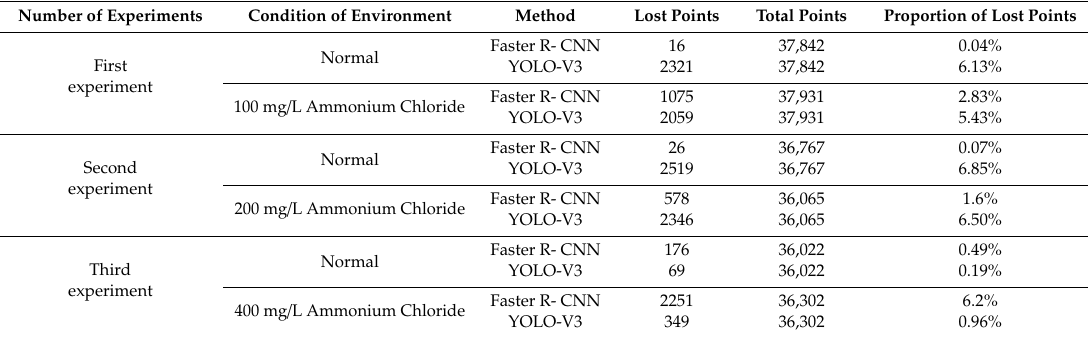
Table 1. Statistics of the missed points.